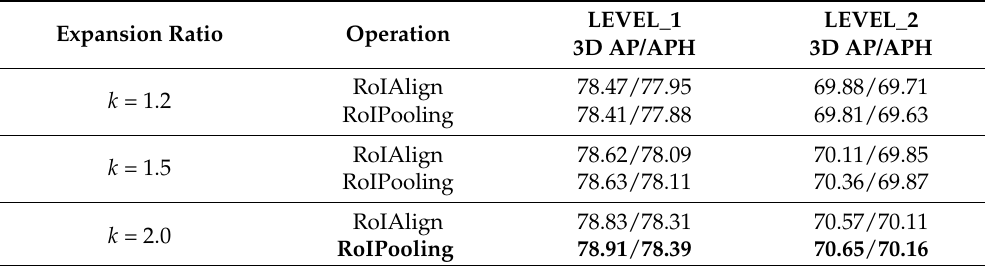
Table 9. Ablations on RoI operations and expansion radio for image features. We report the results on the Waymo dataset with 202 validation sequences. The best results are bolded in the